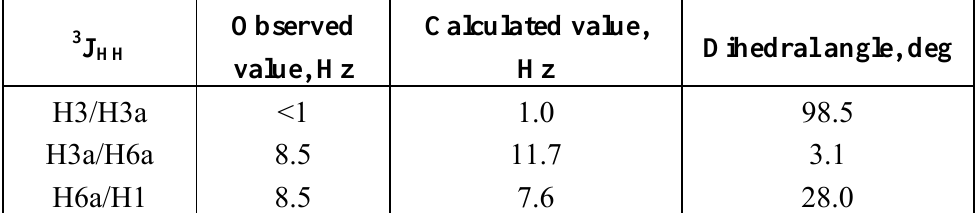
Table 3. Experimental and calculated proton coupling constants for compound 6a